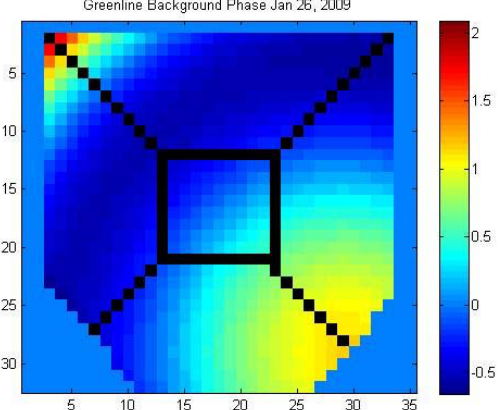
Fig. 2. Green-line background phase (in radians) from 26 Jan- uary 2009. The x- and y-axes represent pixel indices. The blackened bins represent the borders between the sections of the quad mirror. The top section measures east, the bottom, west, the left, south, the right, north, and the centre zenith.